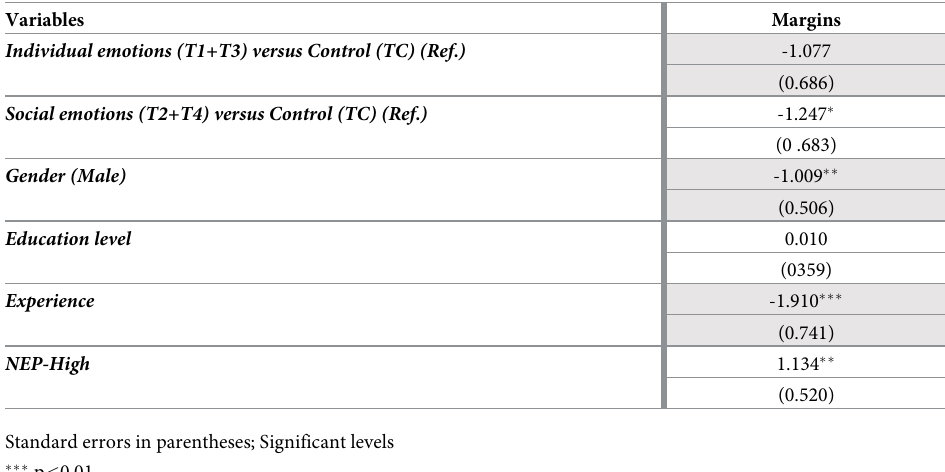
Standard errors in parentheses; Significant levels